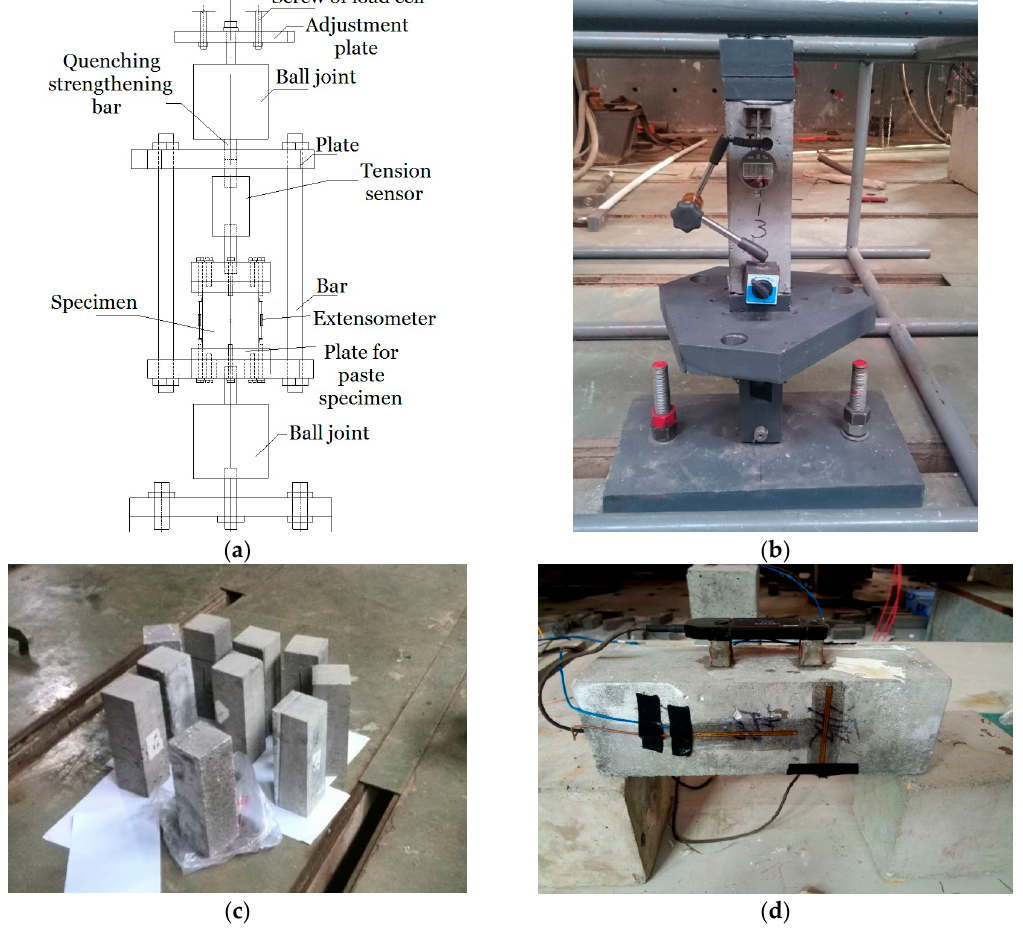
Figure 1. Experimental setup and SCC specimens. ( a , b ) Direct tensile load equipment. ( c ) A picture of specimens after curing. ( d ) The layout of the electrical resistance strain gauges and the extensometer.